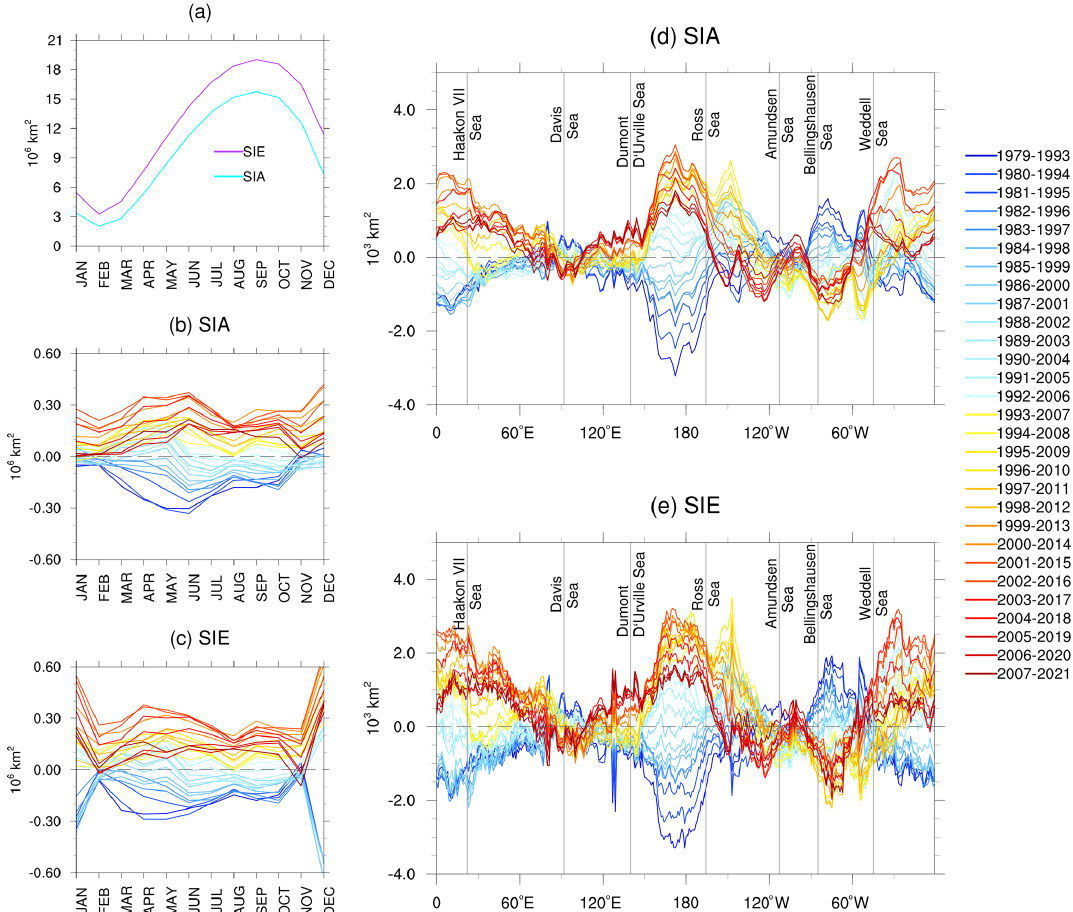
Figure 1. Running 15-year SIA climatology for (a) integrated circumpolar total SIA and SIE, (b–c) difference of each 15-year climatology from the 1979–2021 climatology of SIA and SIE, respectively, and (d–e) differences of regional 15-year annual mean SIA and SIE from 1979–2021 annual means. Lines are coloured from earliest (1979–1993, dark blue) to most recent (2007–2021, dark red) 15-year samples. Vertical lines indicate the approximate mid-point of each geographical location; zero difference from the long-term mean is denoted by the horizontal dotted